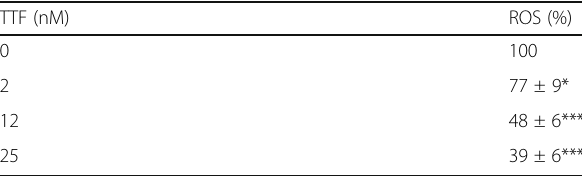
Cells were treated for 20 h with A β at 25 μ M and with various concentrations of TTF. The results represent the means ± SEM of three experiments ( n = 24). *p < 0.05, ***p < 0.001, for comparison with cells that were treated with A β